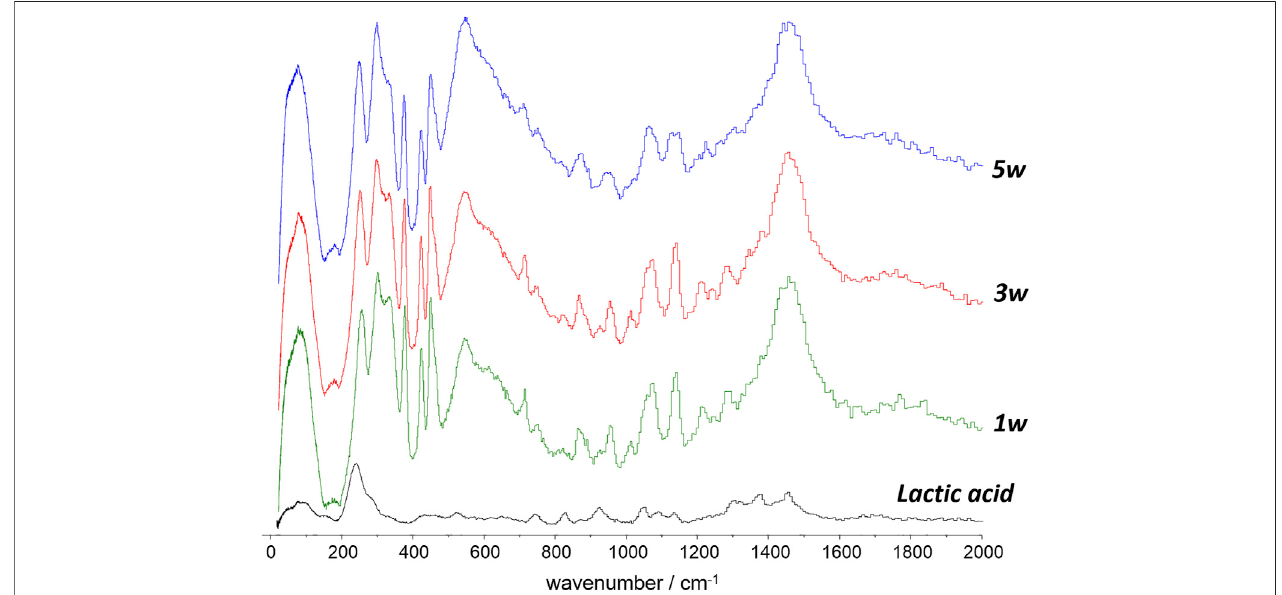
FIGURE9| INS spectraoflacticacidand theChCl:lactic acideutecticmixturewithincreasingwatercontent,inthe0 – 2000 cm − 1 range.Frombottom totop:lactic acid, DES:water molar ratio of 1:1 (ca. 7.3% wt, 1w), 1:3 (ca. 19.0% wt, 3w), and 1:5 (ca. 28.2% wt,